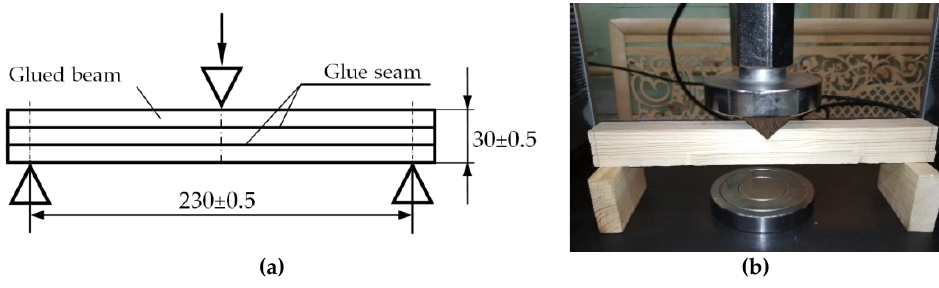
Figure 5. Bending tests: ( a )—scheme of determining the bending strength of the laminated beam; ( b )—photo of determining the bending strength of the laminated beam.